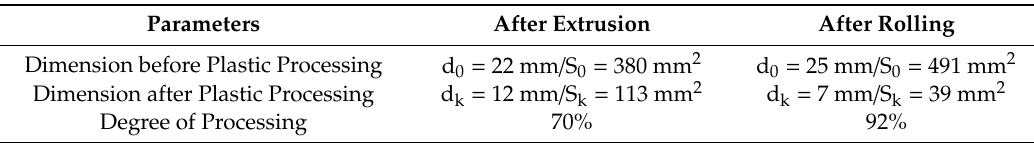
Table 2. Degree of alloy processing Fe40Al5Cr0.2TiB after plastic processing (d 0 —initial